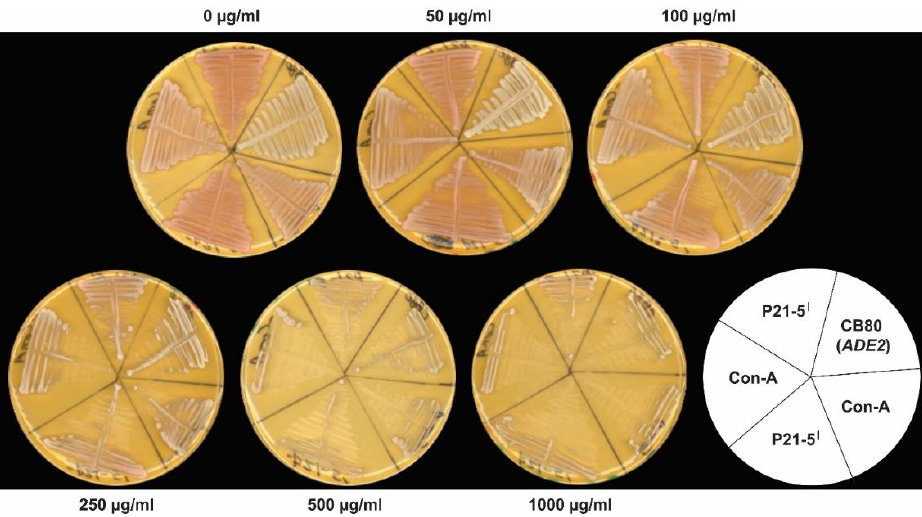
Figure 6. DNA-damage induced transactivation in S. cerevisiae. Isogenic strains yAFM containing the P21-5′ RE and yAFM containing the Con-A RE were used for the gene reporter assays. Both strains require adenine to grow, and the low amounts of adenine in yeast extract in non-synthetic complete (YPD) medium permitted their growth (ref. Materials and Methods). The plate layout of the strains is shown in the bottom right of Figure 6. On the YPD medium, yAFM containing the P21-5′ RE grows light red to pink in color, and yAFM containing the Con-A RE grows light pink. In each experiment, yAFM-P21-5′ and yAFM-Con-A were streaked in duplicate on each plate containing YPD medium alone and on YPD medium containing 50 µ g / mL, 100 µ g / mL, 250 µ g / mL, 500 µ g / mL, and 1000 µ g / mL phleomycin D1. Drug concentrations in each plate are shown. An adenine-non-requiring strain (CB80) also was streaked and is white on all plates. Adenine-requiring ( ade2 ) strains without either of the response elements (REs) were also used as controls in all experiments. The ade2 strains were streaked in triplicate on separate plates in each experiment at each dose, and not squeezed onto the plates with strains bearing REs and the CB80 prototrophic control strain. The ade2 strains grew red on YPD medium without phleomycin. They remained red and did not show any evidence of gene activation, (i.e., they never turned toward white) even at the highest doses, where growth was strongly inhibited. Moreover, no RE gene activation was observed in the ade2 control strains after incubating the plates up to 10 days at room temperature or in the refrigerator. The results shown in Figure 6 are representative of four independent